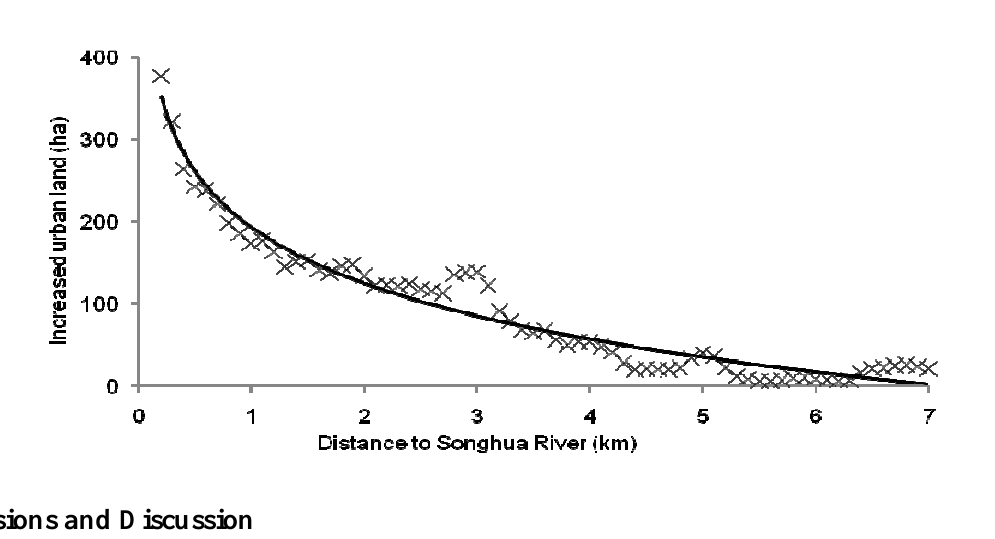
Figure 7. Spatial dependency of land use change from Songhua River between 1989 and